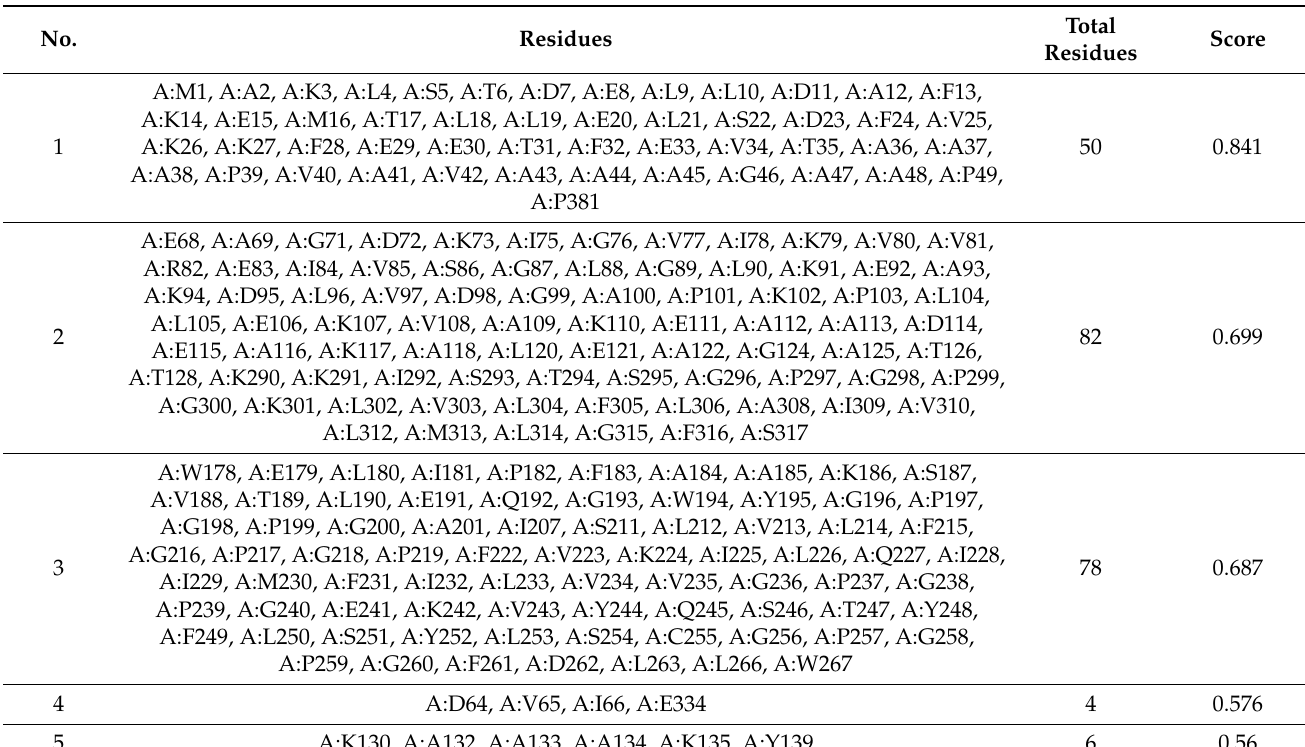
Table 4. Conformational BCEs projected using ElliPro. A total of 220 residues spanned across five discontinuous BCE regions of the refined